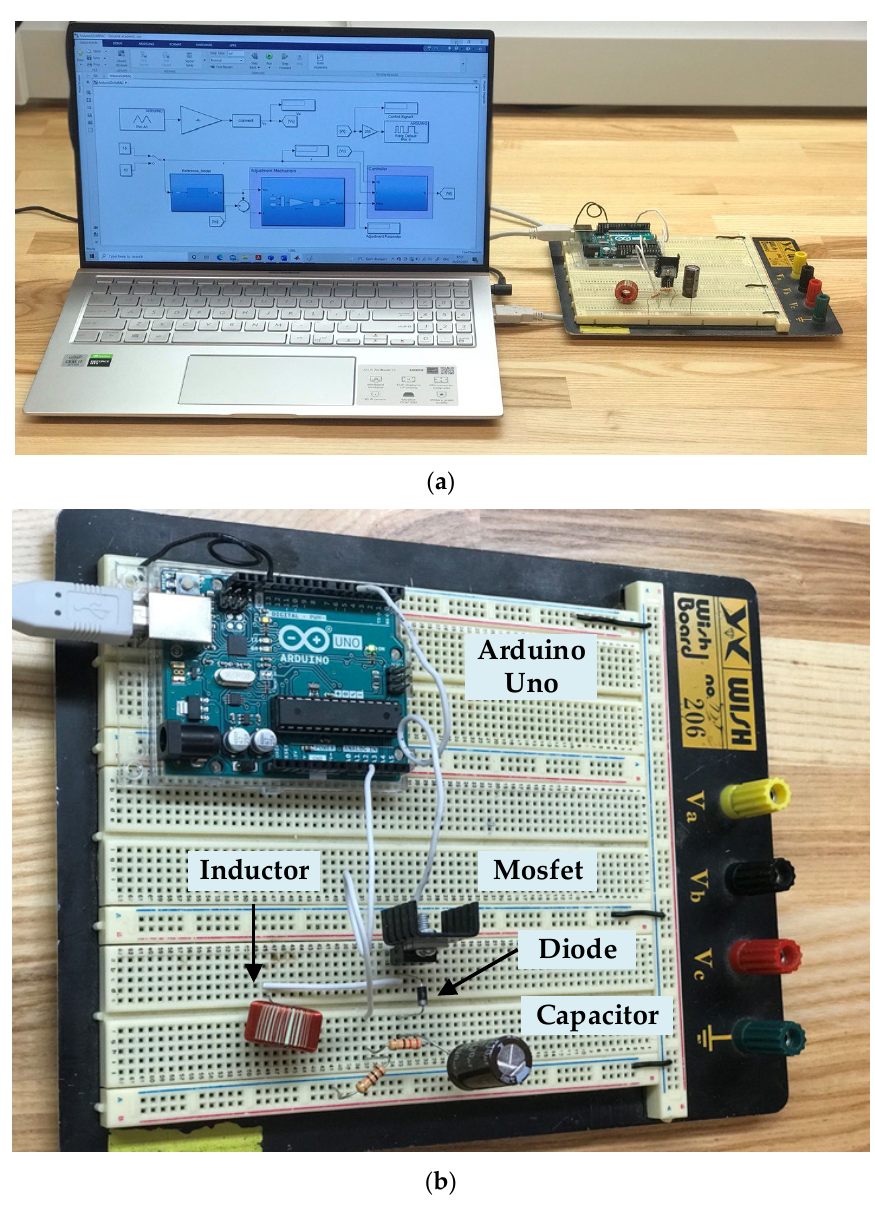
Figure 14. ( a ) Set up connectivity between Simulink and target hardware, ( b ) hardware implemen- tation.